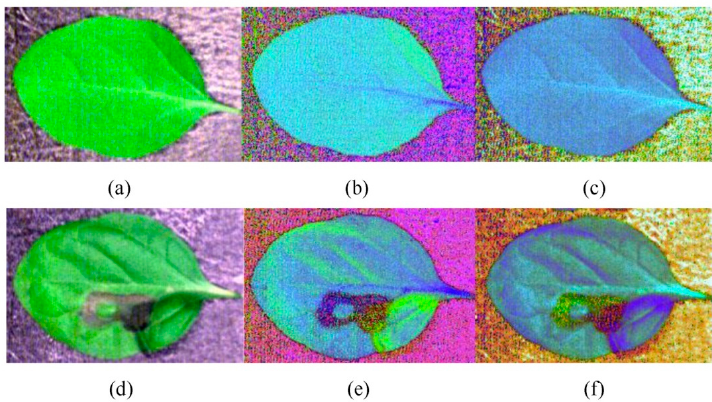
Figure 7. The healthy image in ( a ) RGB; ( b ) HSV and ( c ) HLS color spaces; the diseased image in ( d ) RGB; ( e ) HSV and ( f ) HLS color spaces.